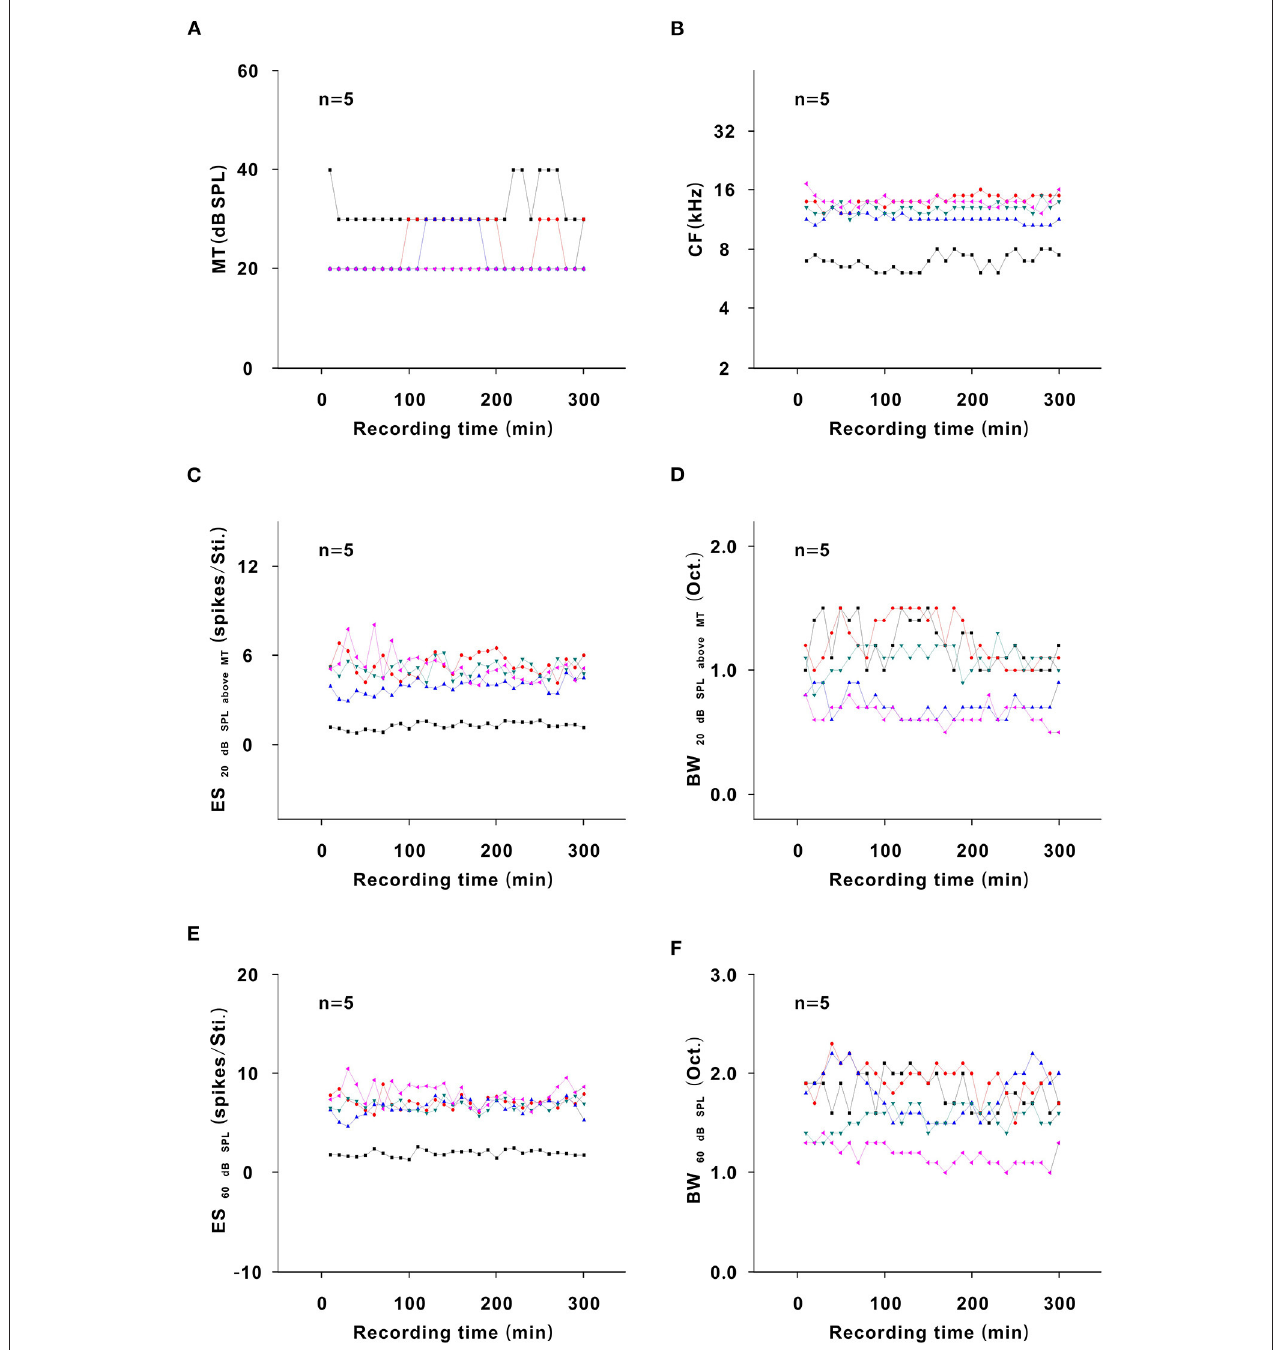
FIGURE 11 | Changes in neuron response in an awake state without urethane anesthesia. (A) Summary of the MT-time curves in neurons [first four recording sessions vs. middle four recording sessions vs. last four recording sessions (22.500 ± 5.590) vs. (26.000 ± 5.477) vs. (23.500 ± 5.477) dB SPL, F = 0.534, P = 0.599, one-way ANOVA]. (B) Summary of the CF-time curves in neurons [first four recording sessions vs. middle four recording sessions vs. last four recording sessions (11.860 ± 2.944) vs. (11.743 ± 2.918) vs. (12.081 ± 2.937) kHz, F = 0.017, P = 0.983, one-way ANOVA]. (C) Summary of the ES 20 dB SPL above MT -time curves in neurons [first four recording sessions vs. middle four recording sessions vs. last four recording sessions (4.270 ± 2.119) vs. (4.119 ± 1.662) vs. (4.224 ± 1.709) spikes/Sti., F = 0.009, P = 0.991, one-way ANOVA]. (D) Summary of the BW 20 dB SPL above MT -time curves in neurons [first four recording sessions vs. middle four recording sessions vs. last four recording sessions (0.956 ± 0.238) vs. (1.030 ± 0.391) vs. (0.900 ± 0.239) Oct., F = 0.237, P = 0.792, one-way ANOVA]. (E) Summary of the ES 60 dB SPL -time curves in neurons [first four recording sessions vs. middle four recording sessions vs. last four recording sessions (6.038 ± 2.699) vs. (6.221 ± 2.353) vs. (6.342 ± 2.626) spikes/Sti., F = 0.018, P = 0.982, one-way ANOVA]. (F) Summary of the BW 60 dB SPL -time curves in neurons [first four recording sessions vs. middle four recording sessions vs. last four recording sessions (1.690 ± 0.328) vs. (1.610 ± 0.357) vs. (1.665 ± 0.348) Oct., F = 0.070, P = 0.932, one-way ANOVA].